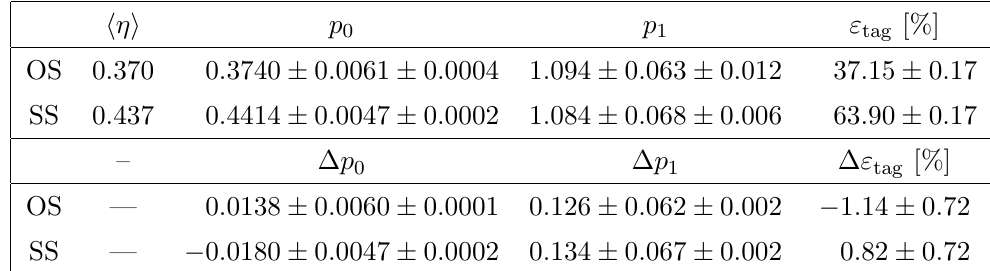
Table 1 . Calibration parameters and tagging asymmetries of the OS and SS taggers obtained from B 0 D (cid:0) (cid:25) + decays. The (cid:12)rst uncertainty is statistical and the second is systematic. s ! s